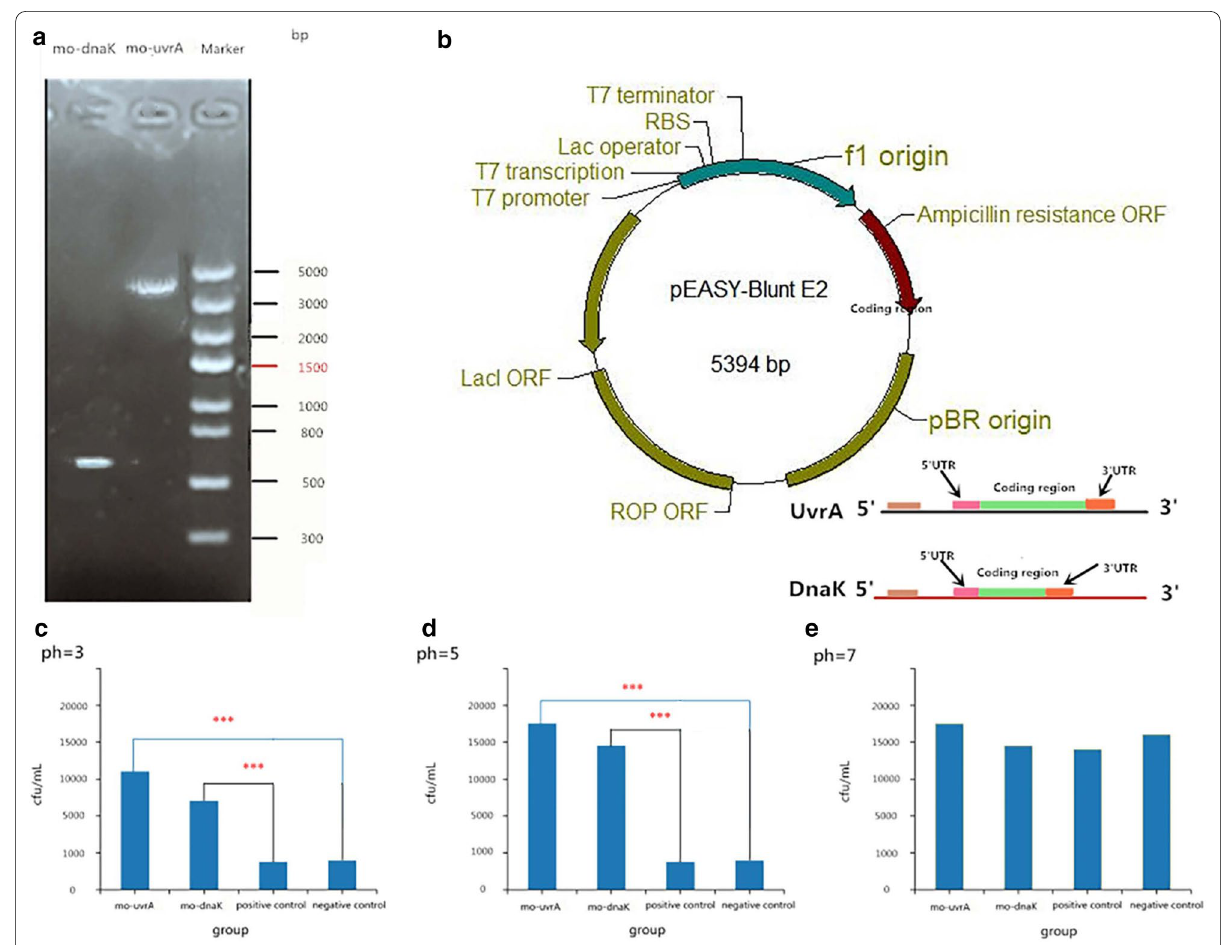
Fig. 2 This picture has five part. a The gel electrophoresis pattern after PCR amplification of the two genes. b The structure of the plasmid used in the experiment. c , d , e Acid resistance analysis results, CFU index at three different pH